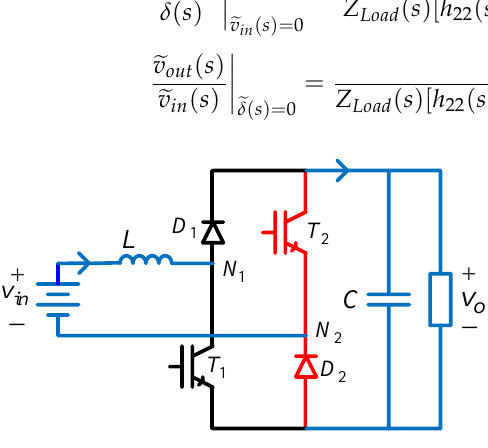
Figure 13. Current-fed full-bridge DC-DC converter.